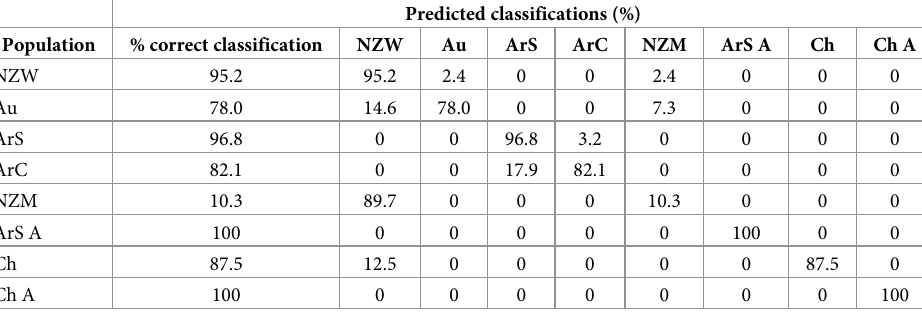
australis from Western Australia measured by Potter et al. [32]. As raw data from Potter et al. [32] were unavailable, analyses are limited to descriptive comparisons of means and 95% confi- dence limits. The prebranchial length of mature male and female G . australis was, on average, respectively 13.2 and 12.1% of their total length in Australia [32] and 15.5% of their total length (sexes combined) in Chile, whereas the mean prebranchial length of G . macrostoma (sexes combined) measured 12.0–12.9% of their total length upon entry to fresh water (Table 1). As G . macrostoma becomes sexually mature, the prebranchial length measures up to 23.7% of their total length (Table 1). The oral disc of G . macrostoma also undergoes greater growth through to maturity than that of G . australis . Upon entry to fresh water, the oral disc length of G . australis averaged 2.8– 3.8% of their total length (Table 1), whereas the oral disc length of G . macrostoma averaged 5.3–6.3% of their total length (Table 1). Once G . australis reaches sexual maturity, Potter et al. [32] found the average oral disc length had increased to around 5% of their total length, with Table 3. Classification matrix from the discriminant function analysis on morphometric characters among the eight lamprey populations (NZW: Waikawa River, New Zealand; NZM: Mokau River, New Zealand; Au: Murray River, Australia; ArC: Chubut River, Argentina; ArS: Santa Cruz River, Argentina; Ch: Temuco, Chile; ArS A: Mature adult lamprey from the Santa Cruz River, Argentina; Ch A: Mature adult lamprey from four Chilean rivers).